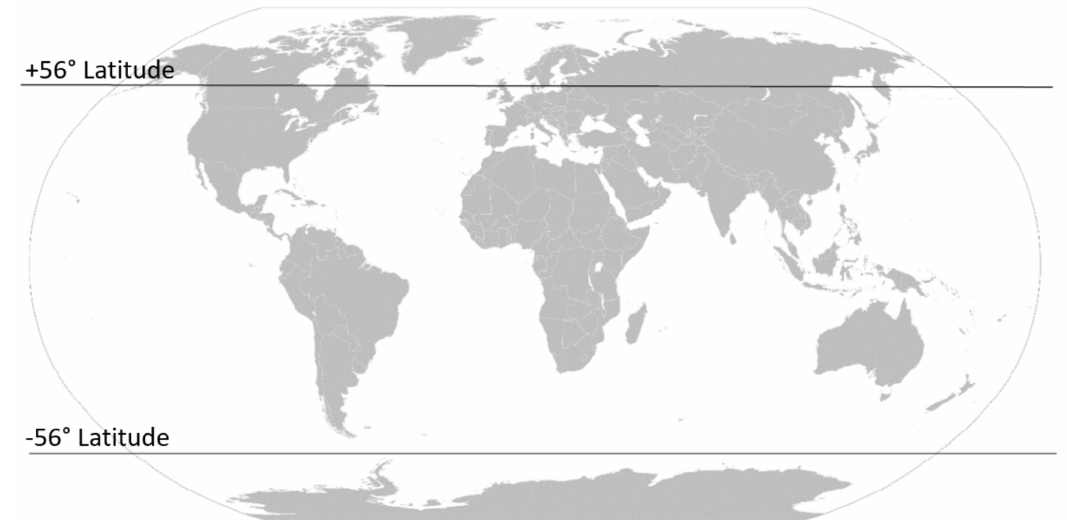
Figure 8. Robinson projection map of the world with lines of ± 56 ◦ latitude indicated. Regions of the Earth close to these latitudes would experience coverage similar to Scotland from the proposed satellite